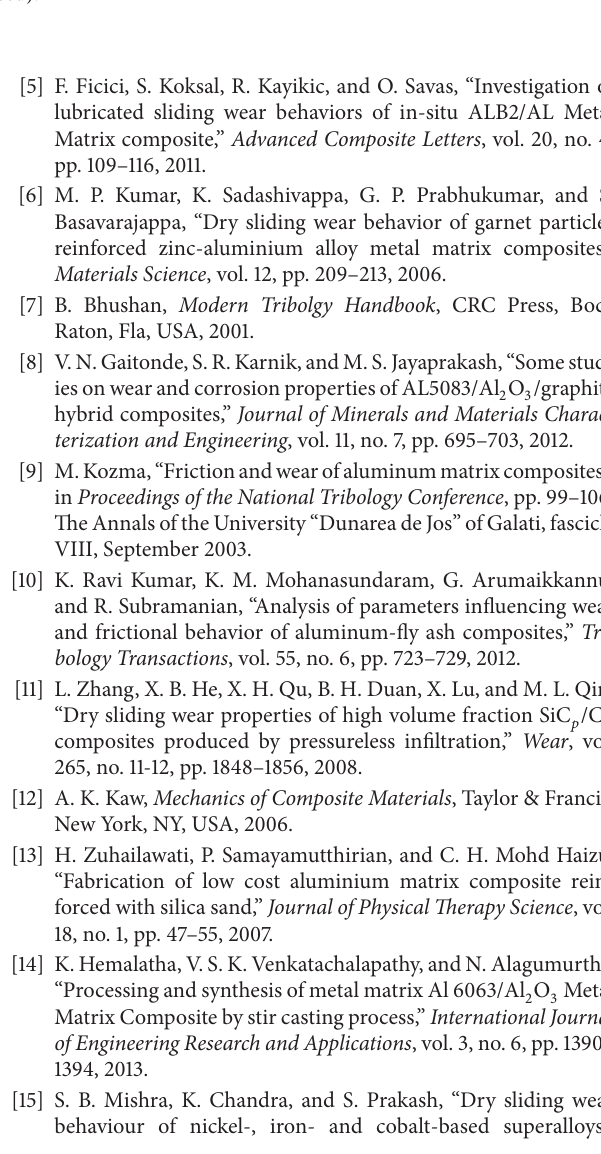
Figure 14: (a) SEM of sample-III at higher magnification before wear test. (b) SEM of wear track of sample-III at higher magnification after wear test (after running 3000 m at 29.43 N load and 4.71m/s sliding